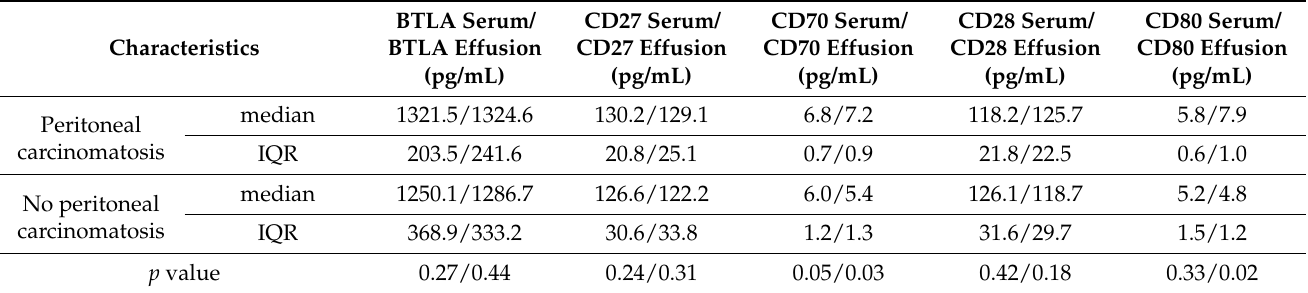
Table 7. Levels of serum and peritoneal fluid concentrations of studied proteins in relation to the presence of peritoneal